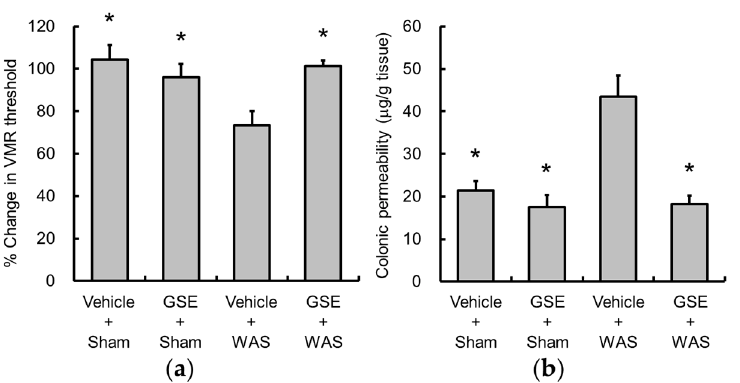
Figure 2. Effects of GSE on water avoidance stress (WAS)-induced visceral allodynia ( a ) and colonic hyperpermeability ( b ). GSE reversed the changes induced by WAS. Data are presented as the mean ± S.E.M ( n = 6–7). * p < 0.05 vs. Vehicle + WAS group. GSE, grape seed extract, WAS, water avoidance stress.